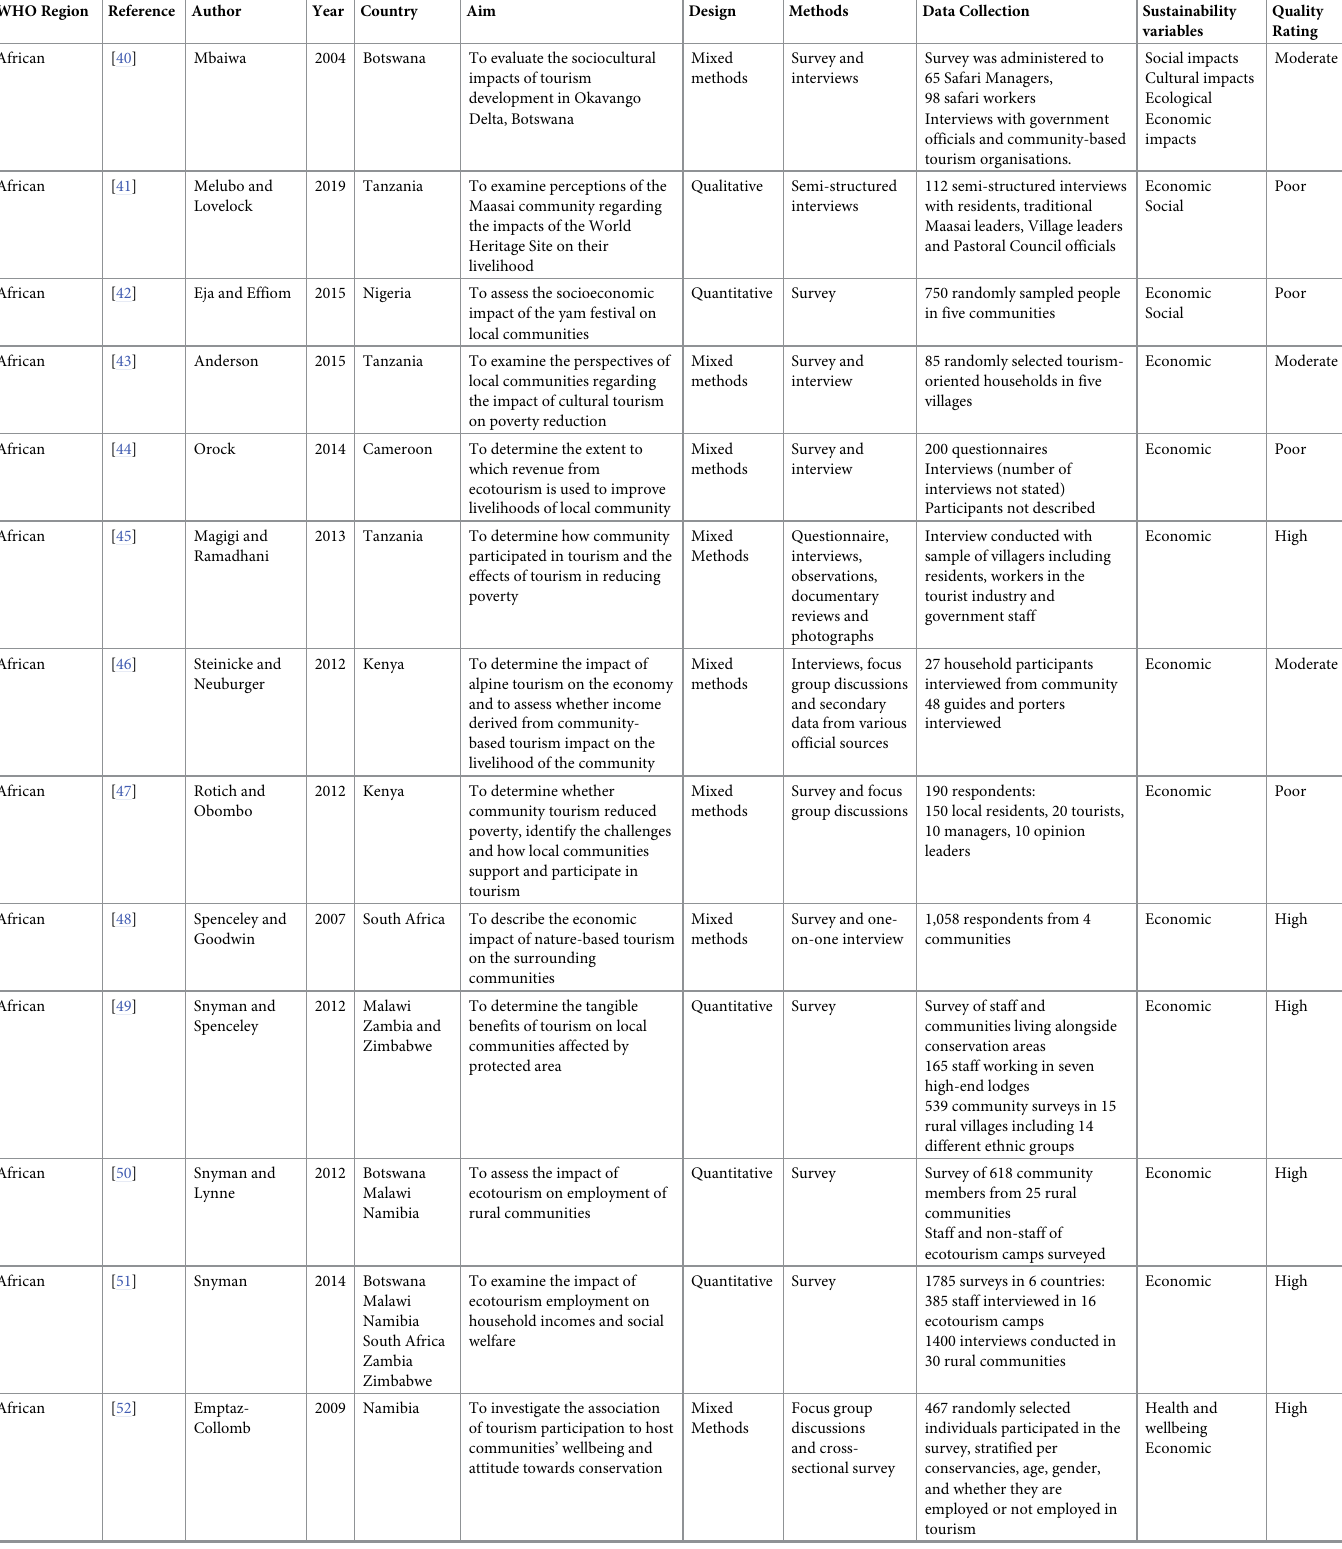
Table 1. Descriptive characteristics and quality assessment for included studies by WHO